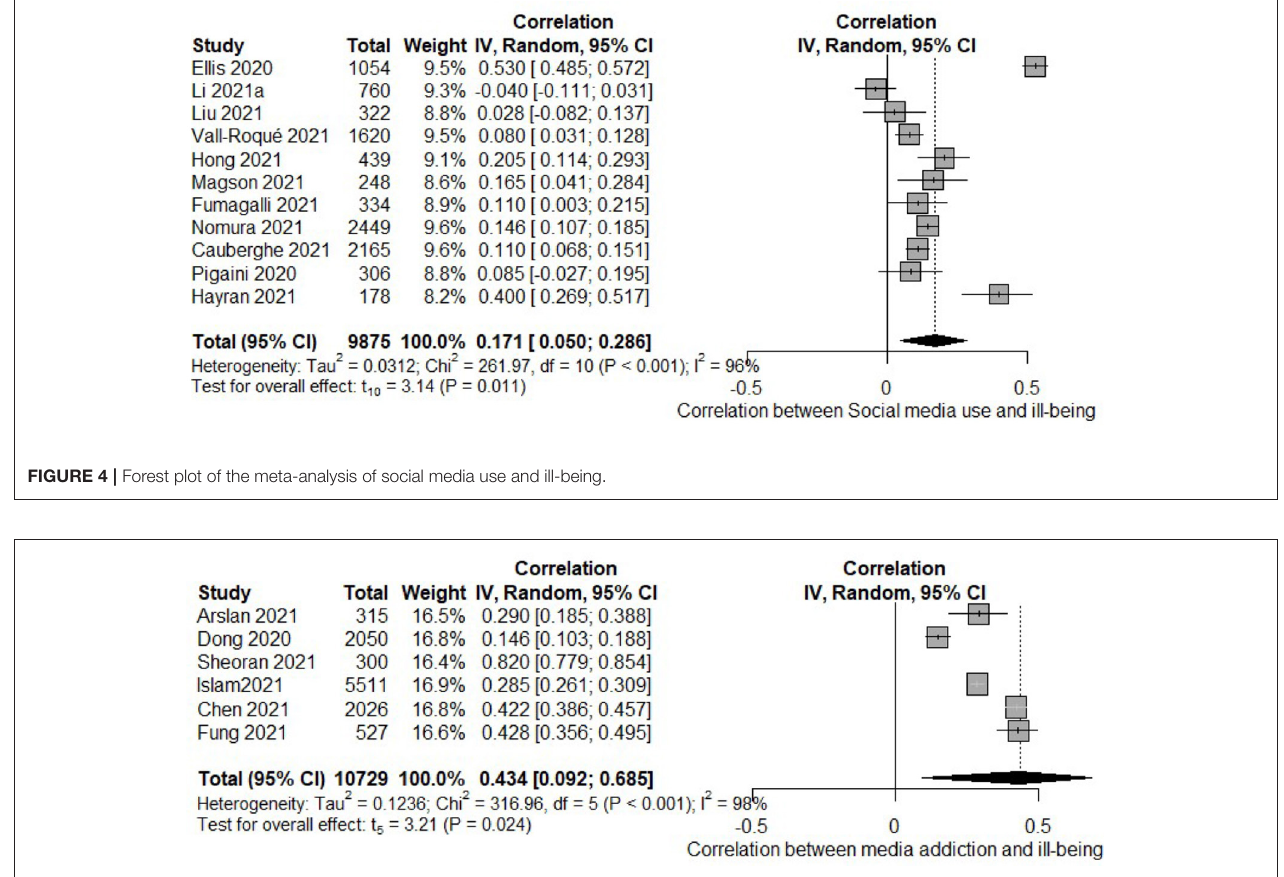
FIGURE 5 | Forest plot of the meta-analysis of media addiction and